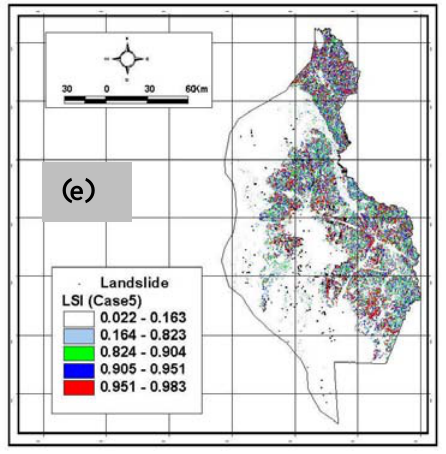
Fig. 2. Landslide susceptibility maps using various fuzzy operators: (a) Application of fuzzy algebraic “sum” operator; (b) Application of fuzzy algebraic “and” operator; (c) Application of fuzzy gamma (λ = 0.8) operator; (d) Application of fuzzy gamma (λ = 0.9) operator; and (e) Application of fuzzy gamma (λ = 0.975) operator